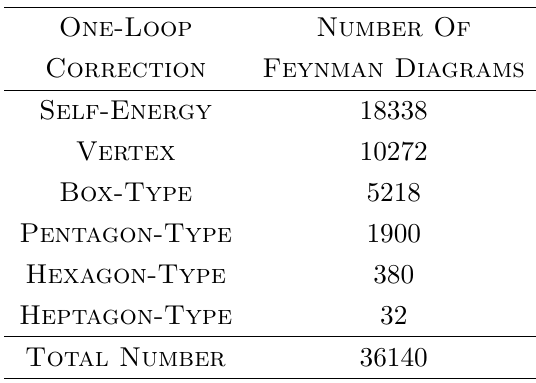
Table 2 . As in table 1 but for the q ¯ q → e + ν e µ − ¯ ν µ b ¯ b τ + τ − partonic